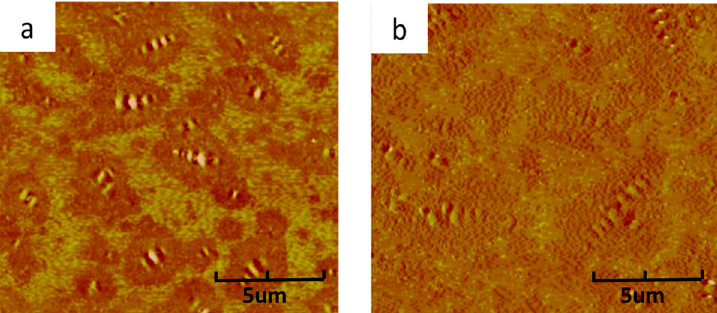
Figure 6. AFM images of regenerated PAV aged bitumen: ( a ) regenerated PAV aged bitumen with 10 wt % CR, ( b ) regenerated PAV aged bitumen with 10 wt % SR.